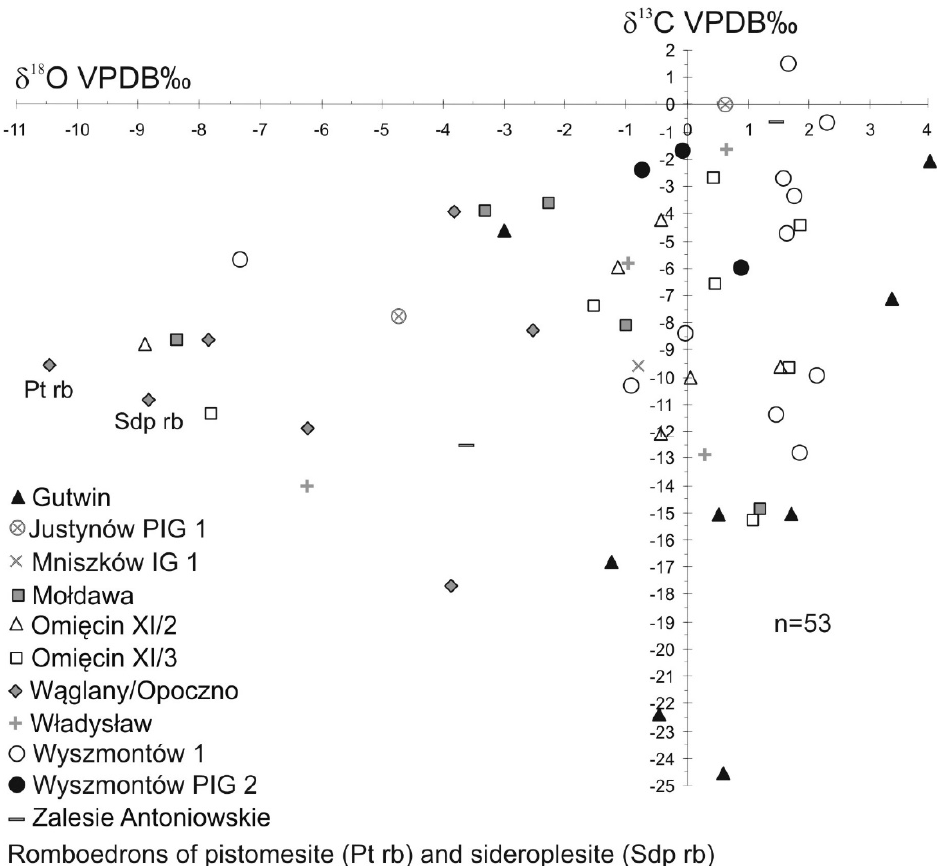
Figure 6. Plot of δ 18 O VPDB ‰ versus δ 13 C VPDB ‰ in siderite cements.